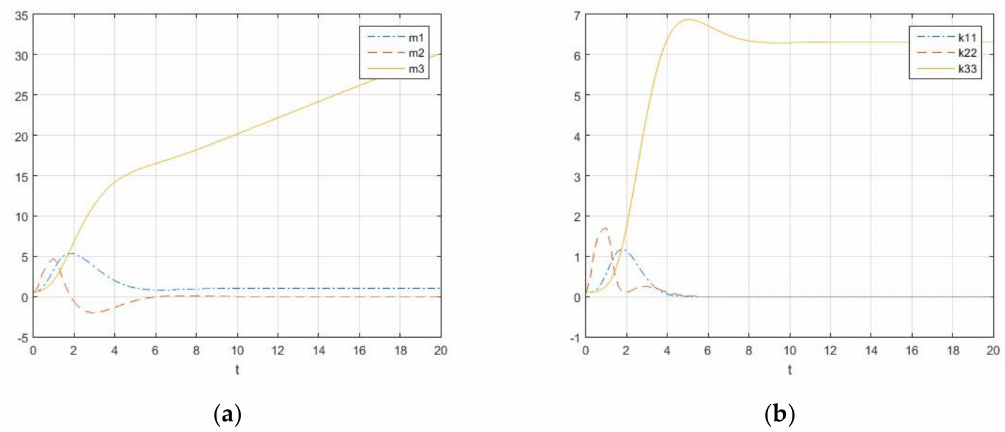
Figure 3. ( a ) Graphs m 1 , m 2 , m 3 at α = 0 ◦ , N = 1; ( b ) Graphs k 11 , k 22 , k 33 at α = 0 ◦ , N = 1.